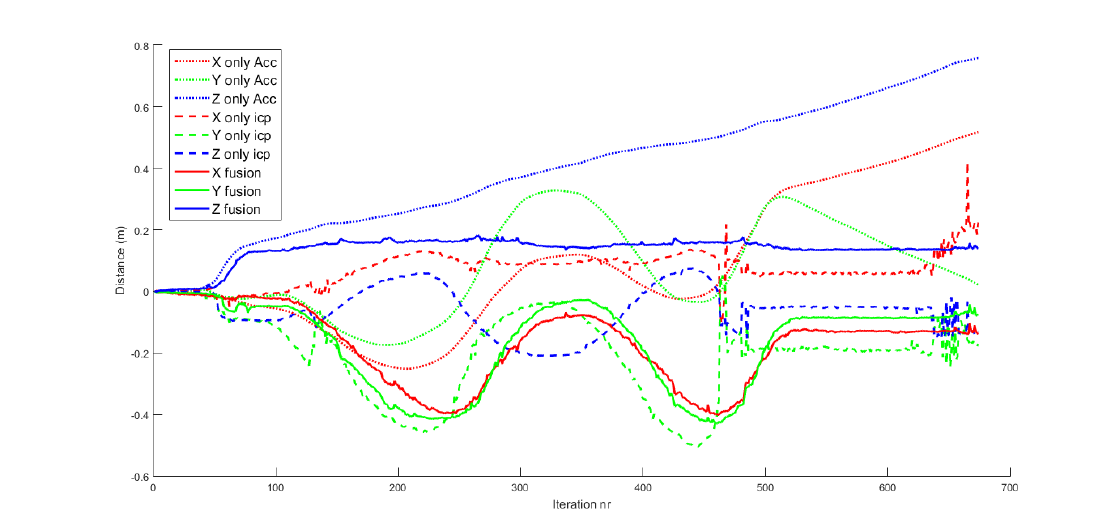
Figure 11. Comparison of drone positioning using the EKF with: only IMU data; only ICP results; fused IMU data and ICP results. Using only IMU data, the position drifts away quickly. Using only ICP results, the position has several bad discrete jumps and does not correspond to actual motion. Using the fused data, the position corresponds to actual